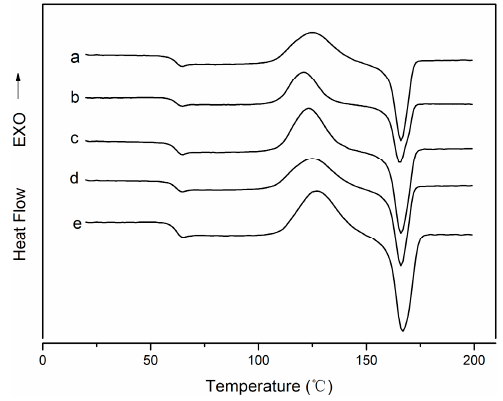
Figure 5. DSC curves of: (a) PLA, (b) PLA/Ti1%, (c) PLA/Ti5%, (d) PLA/Ti1%/Ag, and (e) PLA/Ti5%/Ag.